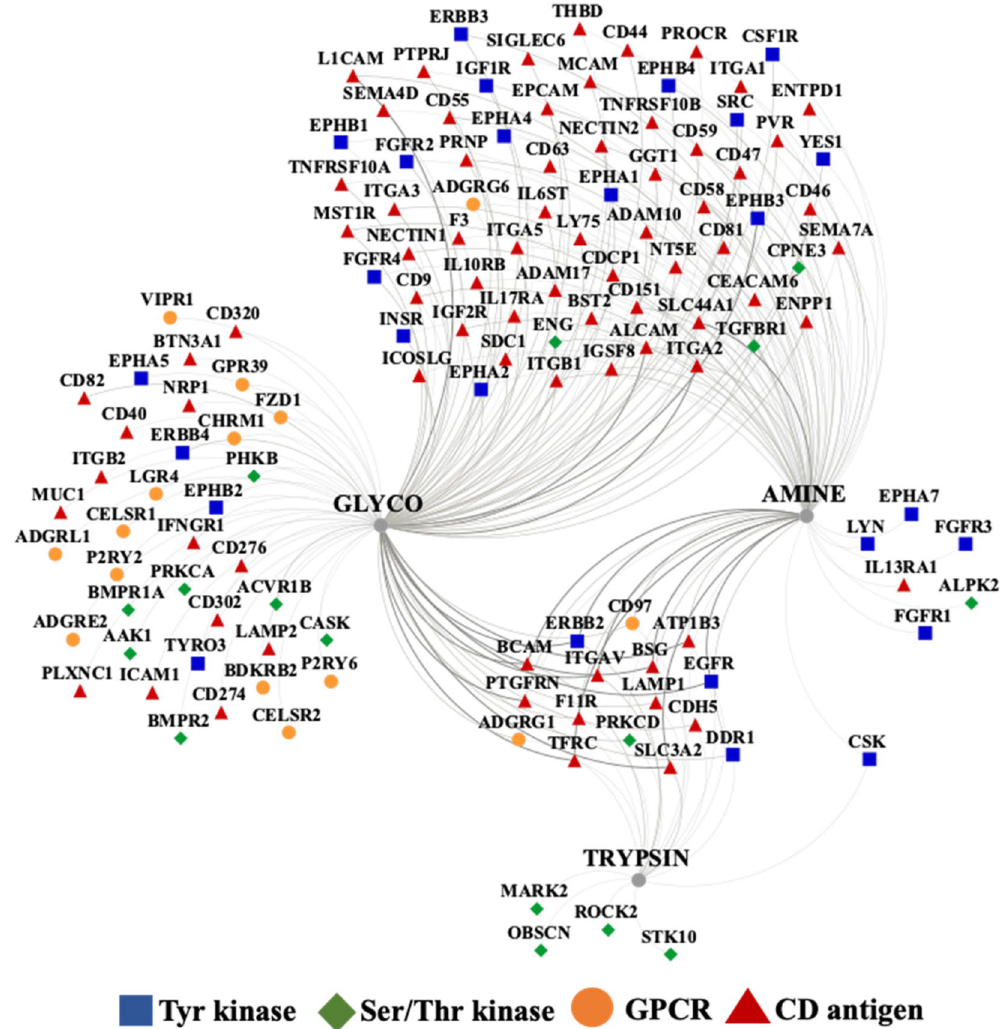
Figure 5. Detectability of cell-membrane receptors and CD proteins. The diagram represents the overlap between the detected proteins produced by the three enrichment methods (visualization performed with Cytoscape); the edge thickness reflects the protein abundance as evidenced by